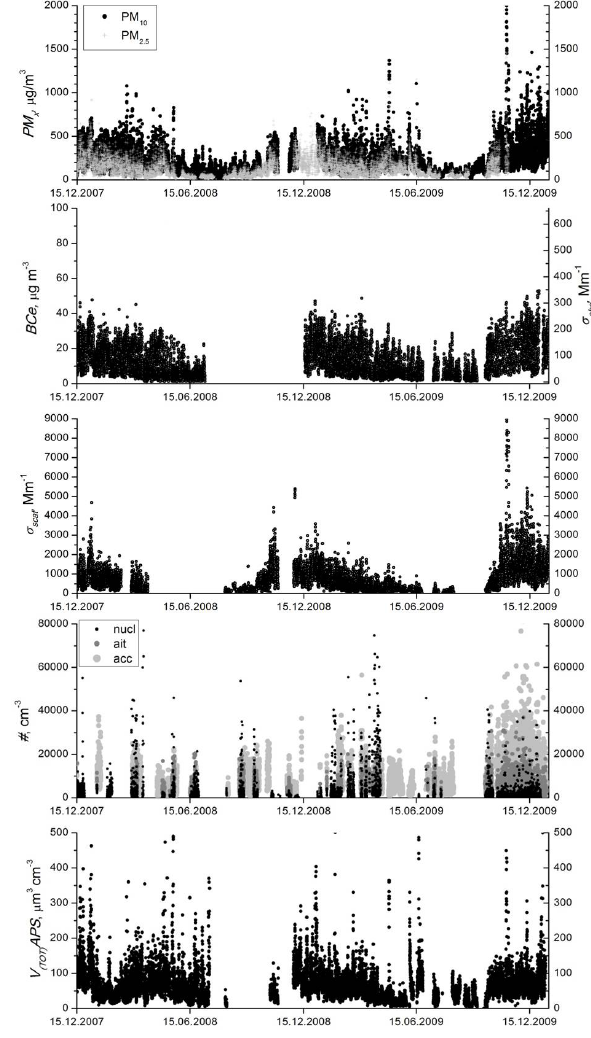
Fig. 4. Aerosol properties at Gual Pahari during the campaign. Each point corresponds to a 1h